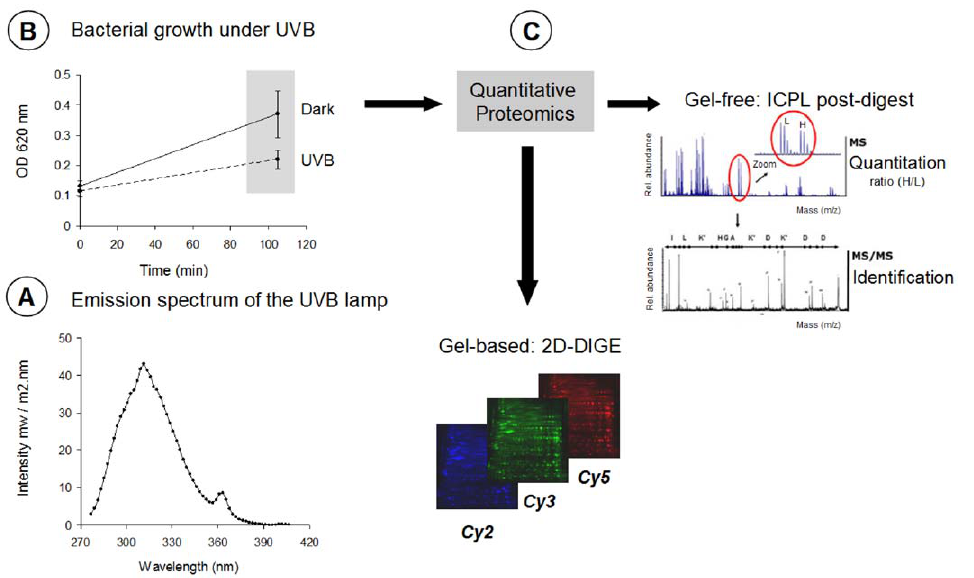
Figure 1. Summary of the experimental workflow. A . Emission spectrum of the UVB lamps used to irradiate the cultured cells of P. angustum B . Bacterial cells were collected at the beginning of log phase (OD=0.1) and cultured either under UVB radiation or in the dark C . After 1.75 h of incubation, quantitative proteomics was performed by using either gel-free (Post-digest ICPL labeling) or gel-based (2D-DIGE) approaches. Quantitative data for ICPL were obtained from the MS spectrum (L: Light label: H: Heavy label).